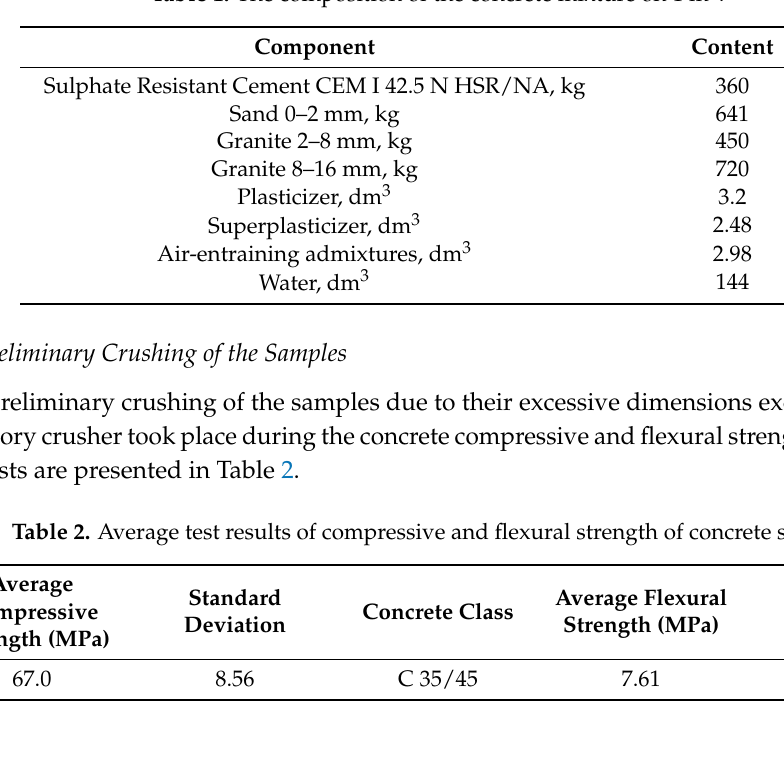
Table 1. The composition of the concrete mixture on 1 m 3 .